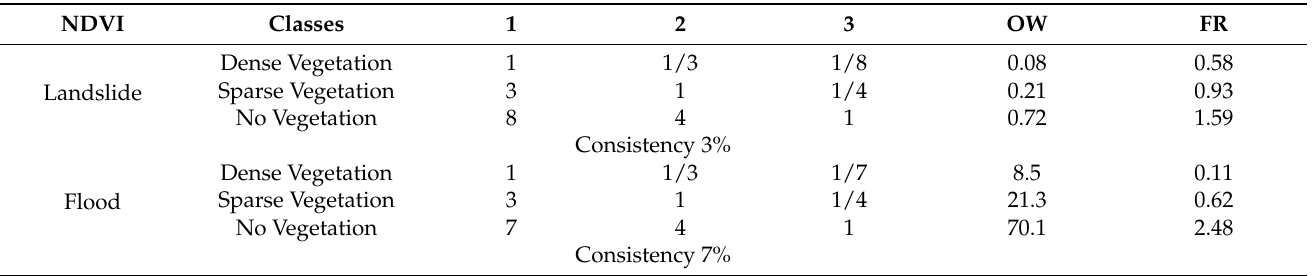
Table 13. AHP matrices and OWs for the NDVI causative factor